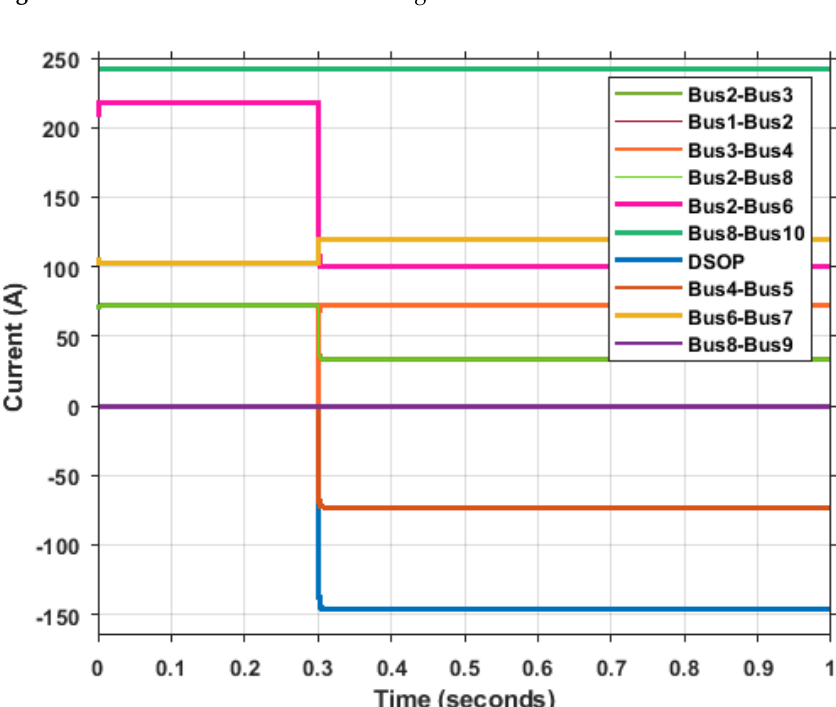
Figure 16. Currents through the DC microgrid feeders before/after connecting the DCSOP.